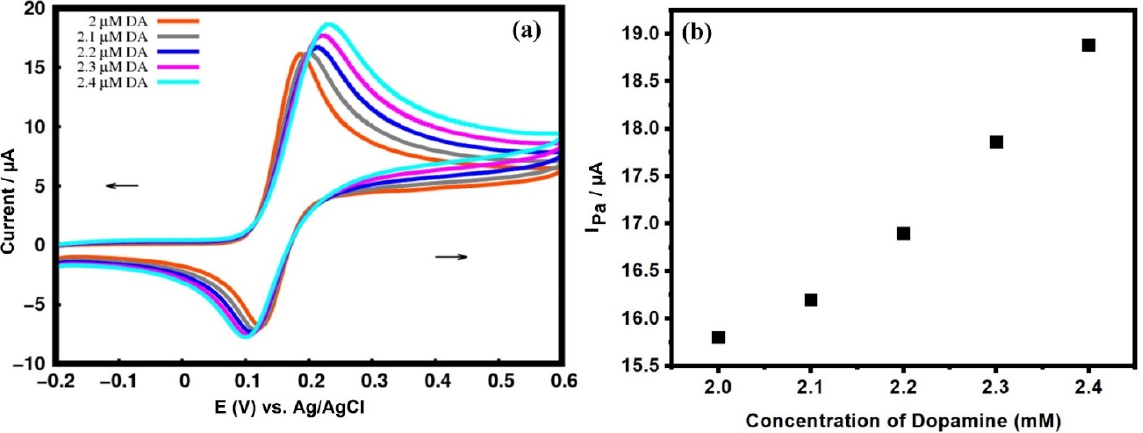
Figure 12. ( a ) The cyclic voltammogram of different concentration of DA. ( b ) Plot of anodic peak current vs. different concentration of DA.